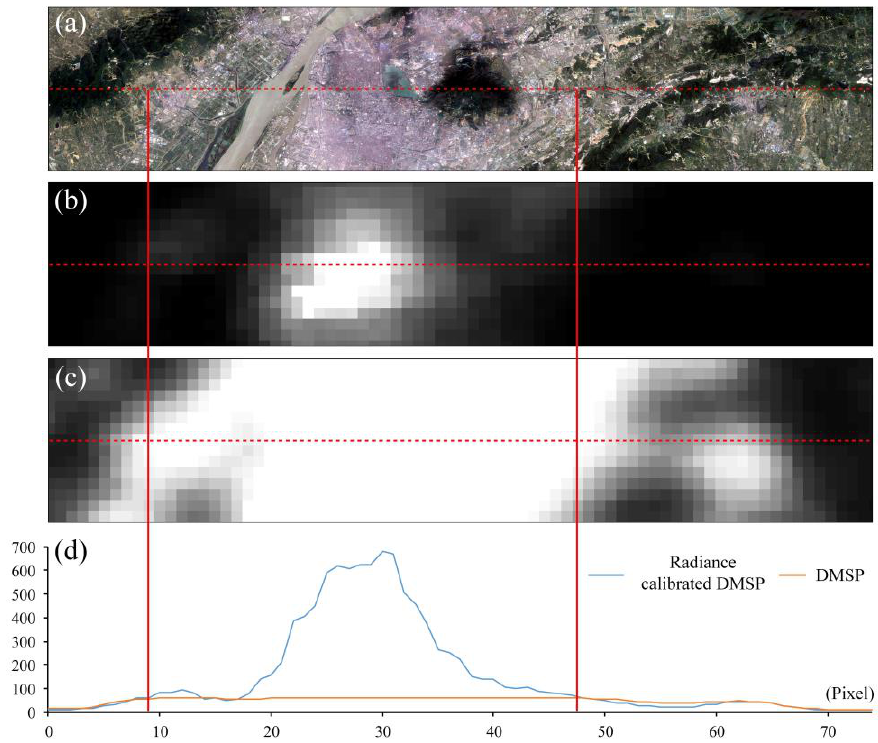
Figure 2. Longitudinal profiles of nighttime light signals across Nanjing. ( a ) Google Earth image; ( b ) Radiance calibrated DMSP nightlight image; ( c ) Original DMSP nightlight image; and, ( d ) Quantitative comparisons of radiance calibrated DMSP nightlight brightness and original DMSP signals.